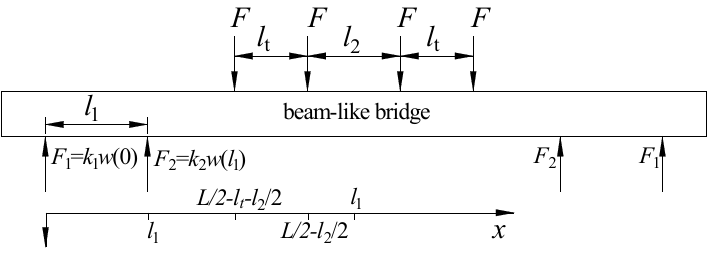
Figure A1. Calculating diagram.